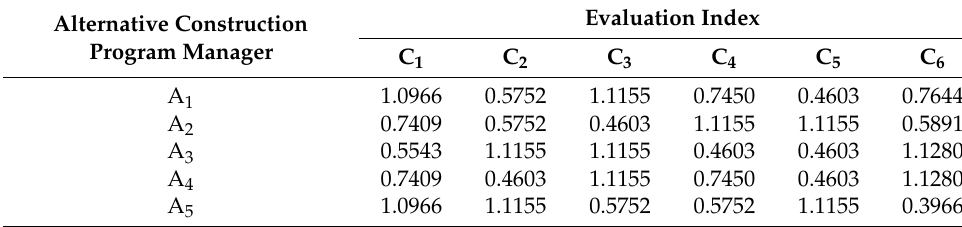
Table 9. Perceived utility value of decision maker D 1 .